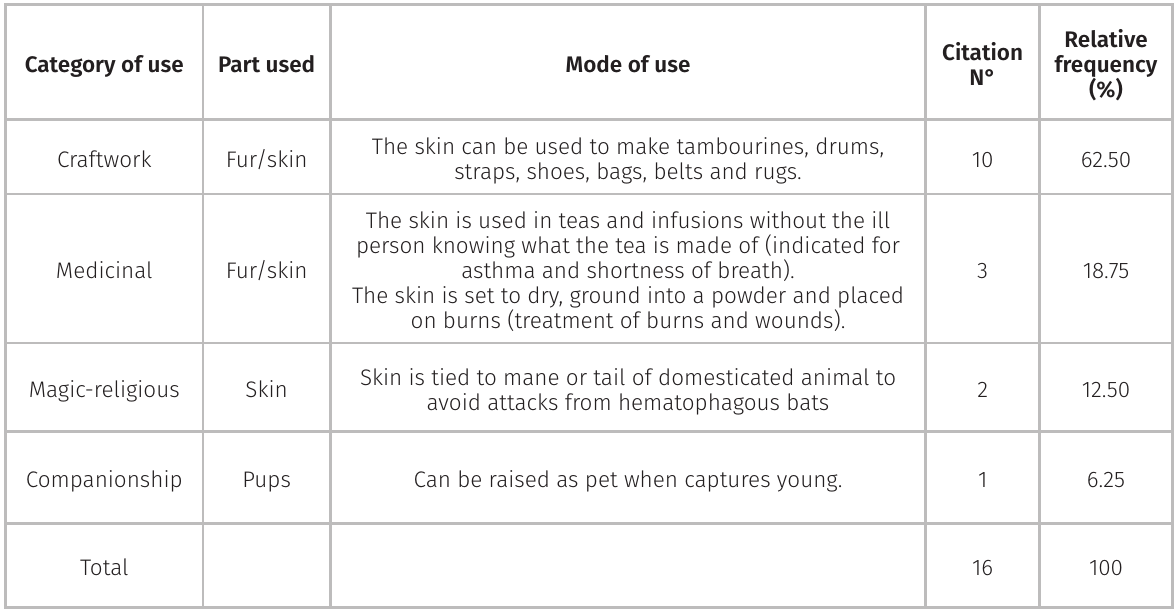
Table III. Forms of use of C. thous identified by the communities studied ( Agreste and coastal forest zone of state of Pernambuco, Brazil).